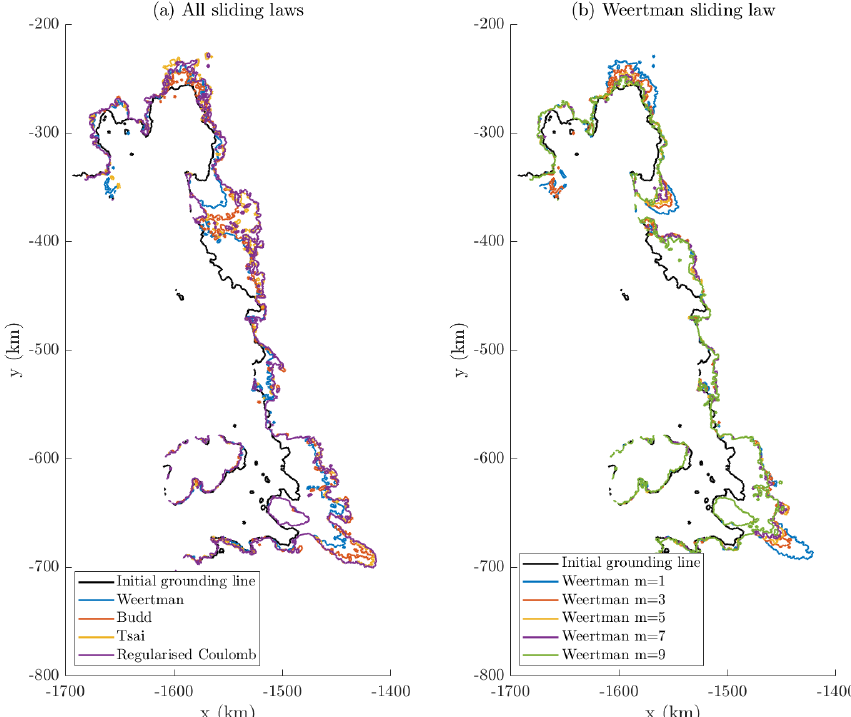
Figure 4. Grounding lines at 120 years in the ice shelf removed branch for (a) all sliding laws using m = 3, q = 1, and µ k = 0 . 5 and (b) different values of m in the Weertman sliding law. The initial grounding line ( t = 0) is also